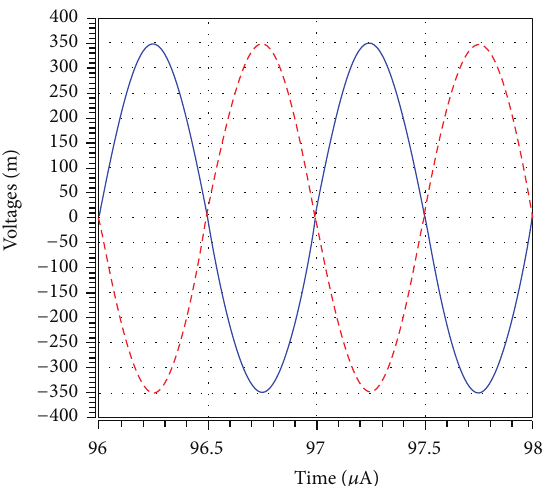
Figure 14: The input (blue line) and output (red line) waveforms of inverting bandpass filter at 𝑉 𝑜5 designed with 𝑅 1 = 𝑅 2 = 𝑅 3 = 𝑅 4 = = 𝐶 = 15.9 pF, for a 1MHz sinusoidal input voltage of 10 k Ω , 𝐶 1 2 0.7 V (peak to